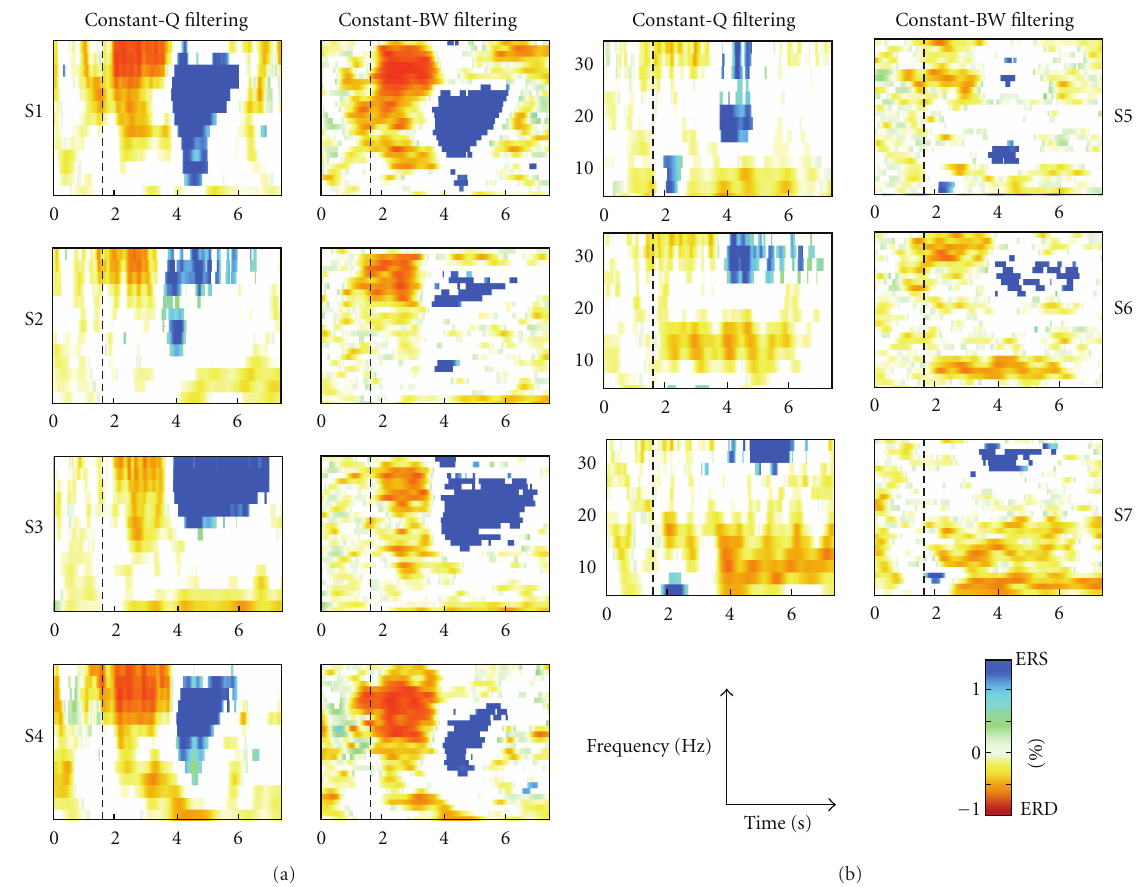
Figure 3: Time-frequency ERD/ERS maps of all subjects, calculated for all 3 runs together. Only significant ( P < 0 . 05) band power changes in 0–7.5 s and in a frequency range 6–35 Hz are displayed. For each subject, constant-bandwidth filters (b) and constant- Q filters are plotted (a). The significant power decrease (ERD) and power increase (ERS) are displayed in red and blue colors, respectively.